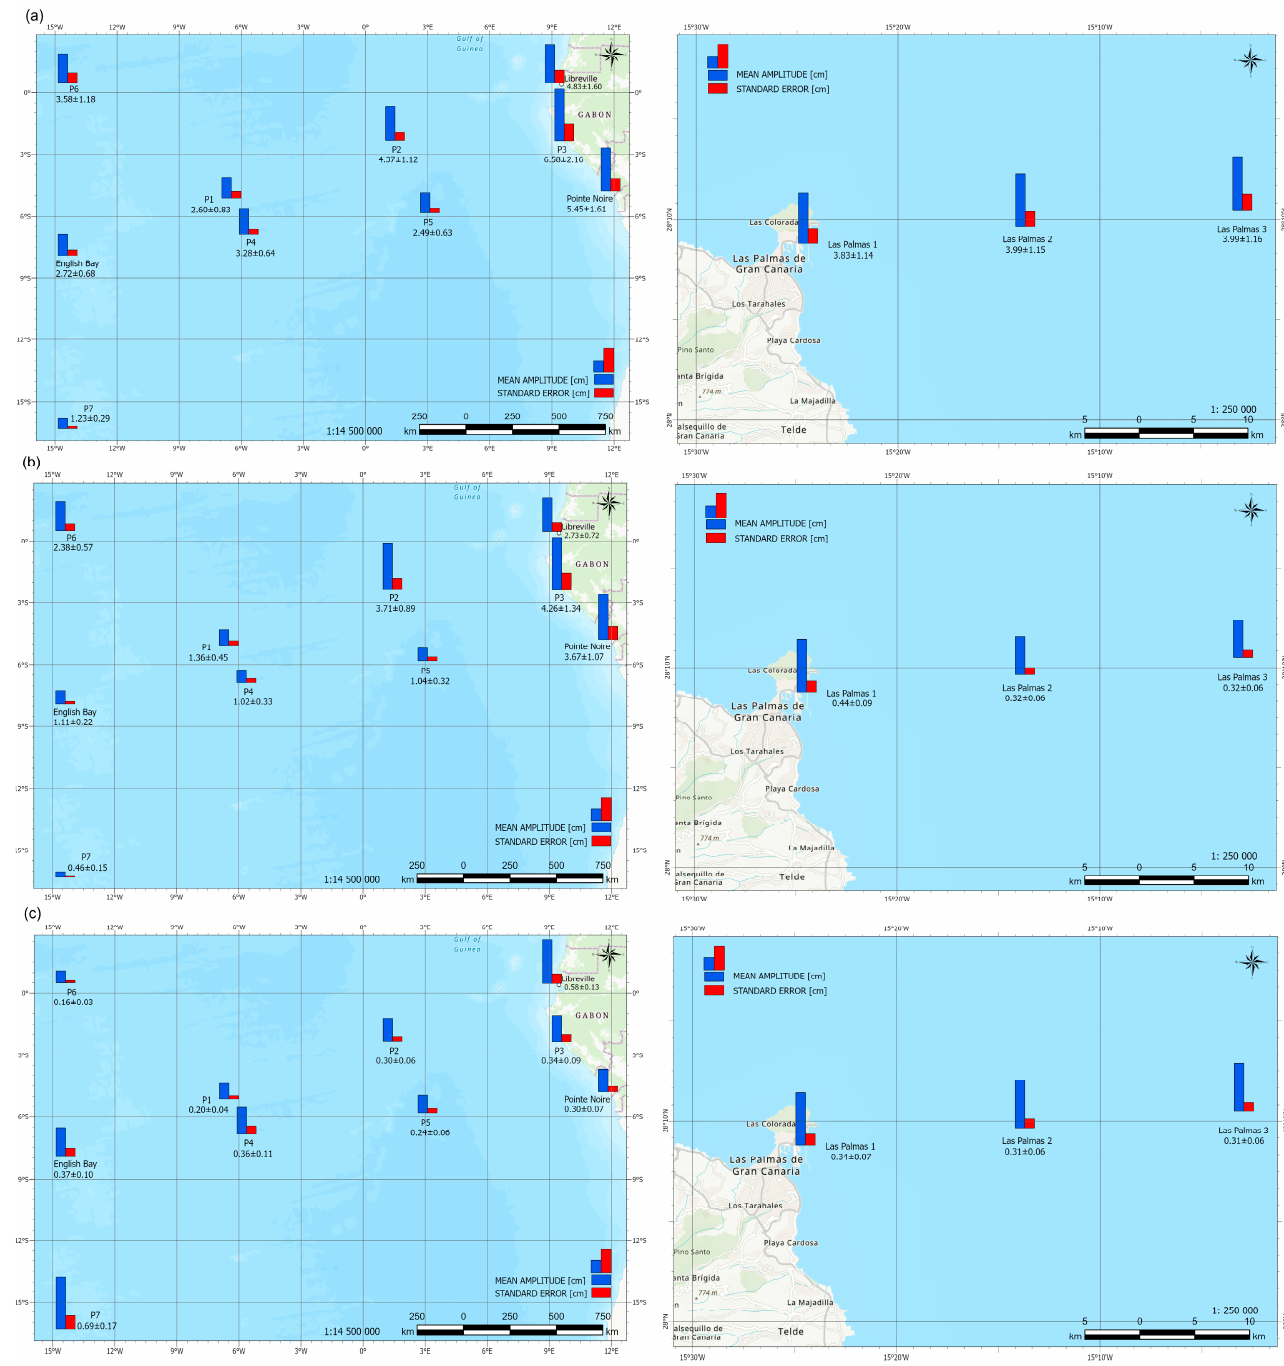
Figure 6. ( a ) Annual, ( b ) semi-annual, and ( c ) 18.61-year amplitudes of the seasonal cycle, based on satellite altimetry time series, in selected points. The amplitude units are centimeters. The final step of the study was to determine the linear relationship, through correlation coefficients, between the trends identified earlier and the elevation of the terrain at all points. The results obtained were presented in Figure 7.